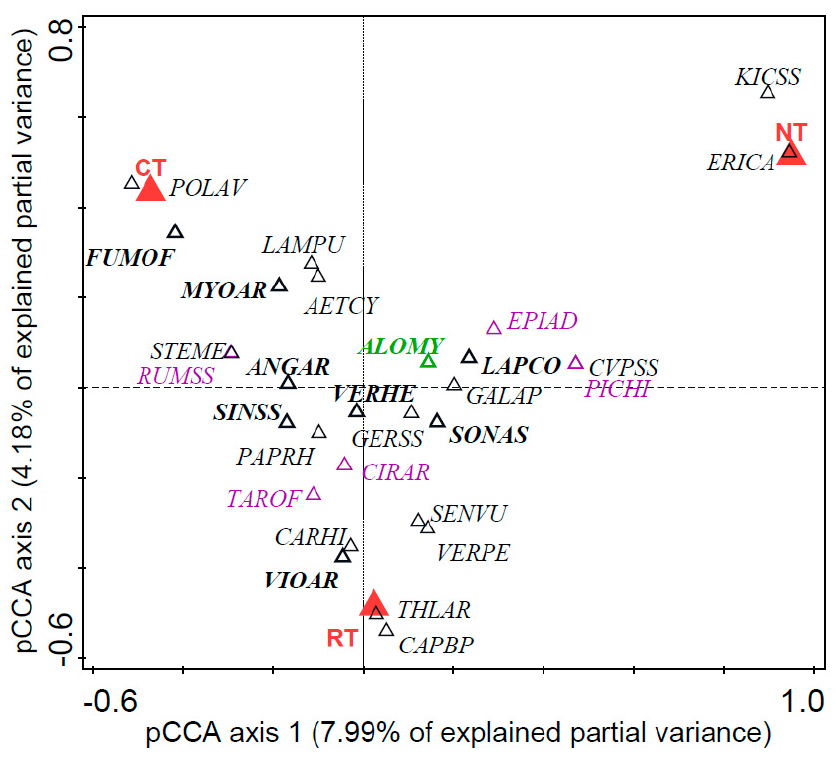
Figure 1. Partial Canonical Correspondence Analysis (pCCA) highlighting the effect of tillage treatments (CT: conventional tillage, RT: reduced tillage, NT: no-till) on weed community composition before weeding, after partialling out field effects. Species are named according to EPPO codes (https://gd.eppo.int/). The 10 most abundant species are highlighted in bold. Species names written in green and purple refer to grasses and pluri-annual species, respectively.